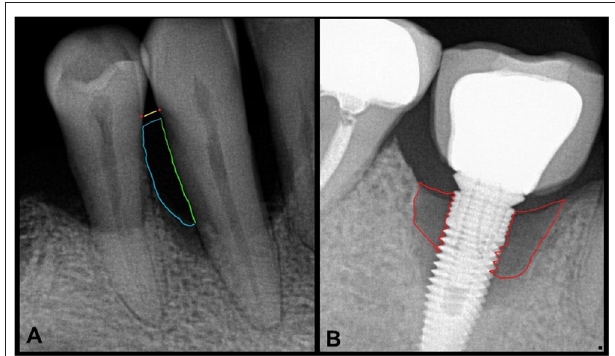
FIGURE 1 | Intraoral radiographs with periodontitis (A) and peri-implantitis (B) . (A) The area of interest to assess bone loss secondary to periodontitis shows a yellow line at the level of CEJs (red dots) of adjacent teeth. The green line depicts the tooth root as a boundary of the region of interest which along with the blue curved line shows the approximate and representative area of complete bone loss. (B) Similarly, areas of most severe peri-implant bone loss are shown by the red